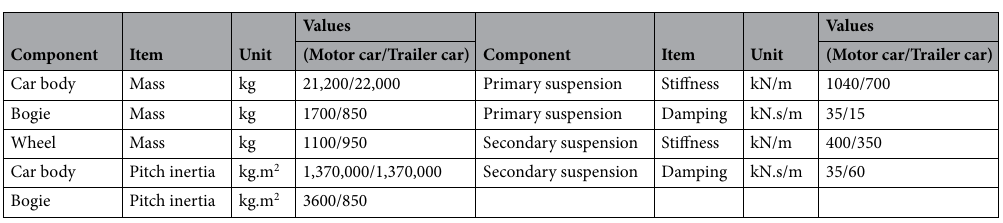
Table 1. The dynamic train